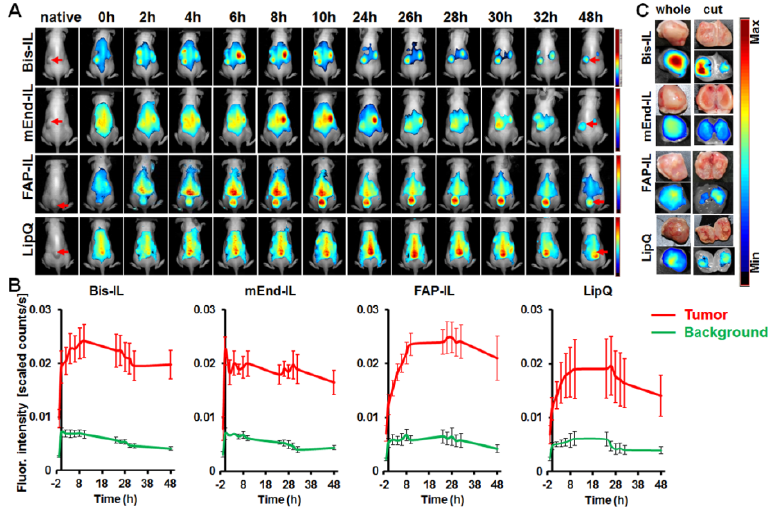
Figure 5. In vivo NIRF imaging of HT1080-hFAP tumors with activatable liposomes. ( A ) Representative NIRF images of mice imaged over 48 h post injection of 20 µ mol (final lipids) / kg body weight of the indicated liposomes. Images per liposomal probe were compared with one another using the Maestro 3.0 software. Color-coded fluorescence: strong (red)-weak (blue). Red arrows depict the tumor. ( B ) Representative plots of the Semi-quantitative levels of the tumor fluorescence intensities after unmixing the autofluorescence. Each line depicts the mean of n = 7 (Bi-FAP / mEnd-IL), n = 3 (mEnd-IL), n = 5 (FAP-IL), n = 5 (LipQ) and the respective standard error, SEM. ( C ) Representative NIRF images of tumors excised from the mice 48 h post injection reveal retention of the liposomes.